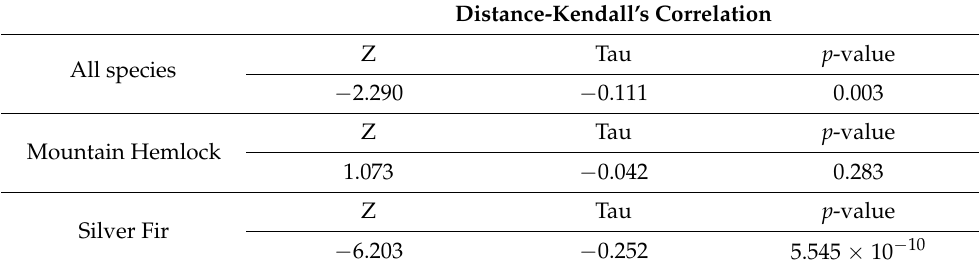
Table 7. Kendall’s correlation between the density of trees established and distance from seed source for the whole study site.